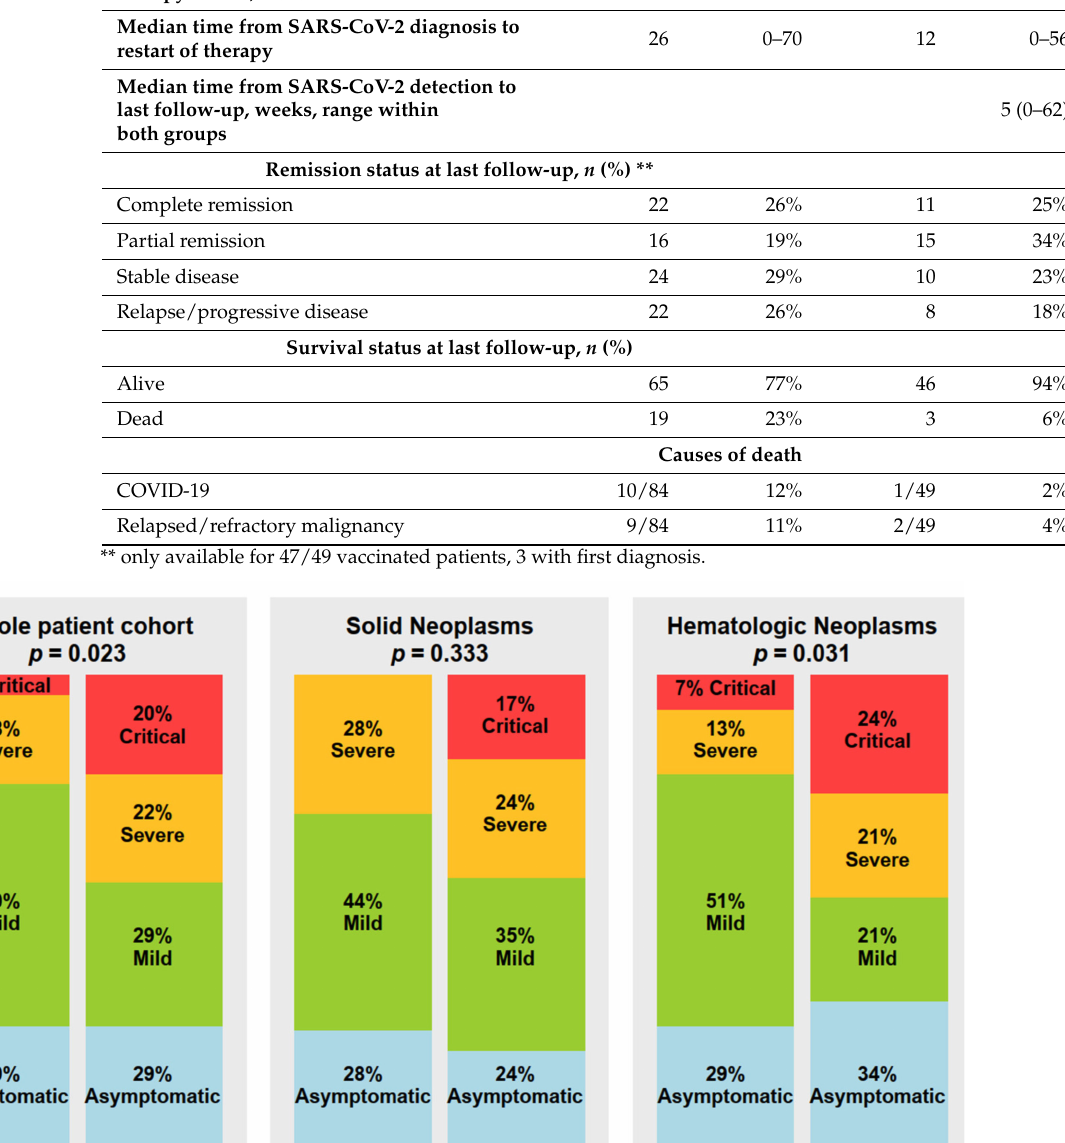
Table 3. Cont. Parameter Non-Vaccinated ( n = 84) Vaccinated ( n = 49) Treatment delay due to SARS-CoV-2 among 69/84 unvaccinated and 34/49 vaccinated patients with ongoing or planned cancer therapy before, n (%)